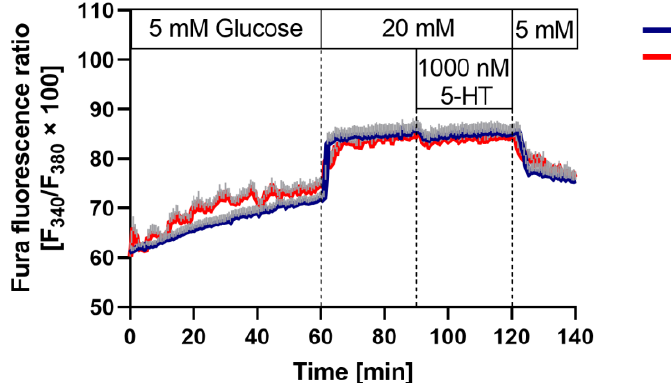
Figure 4. Deviating [Ca 2+ ] i in freshly isolated islets of Langerhans by 5-HT. [Ca 2+ ] i of preconceptional NMRI (blue line) and NZO (red line) mice. Islets were perifused from 0 min to 60 min with medium containing 5 mM glucose. Glucose concentration was increased to 20 mM glucose after 60 min and 1000 nM 5-HT was added after 90 min. This was followed by a 20 min washout period with 5 mM glucose. Data are presented as means ± SEM ( n = 4 animals per group).